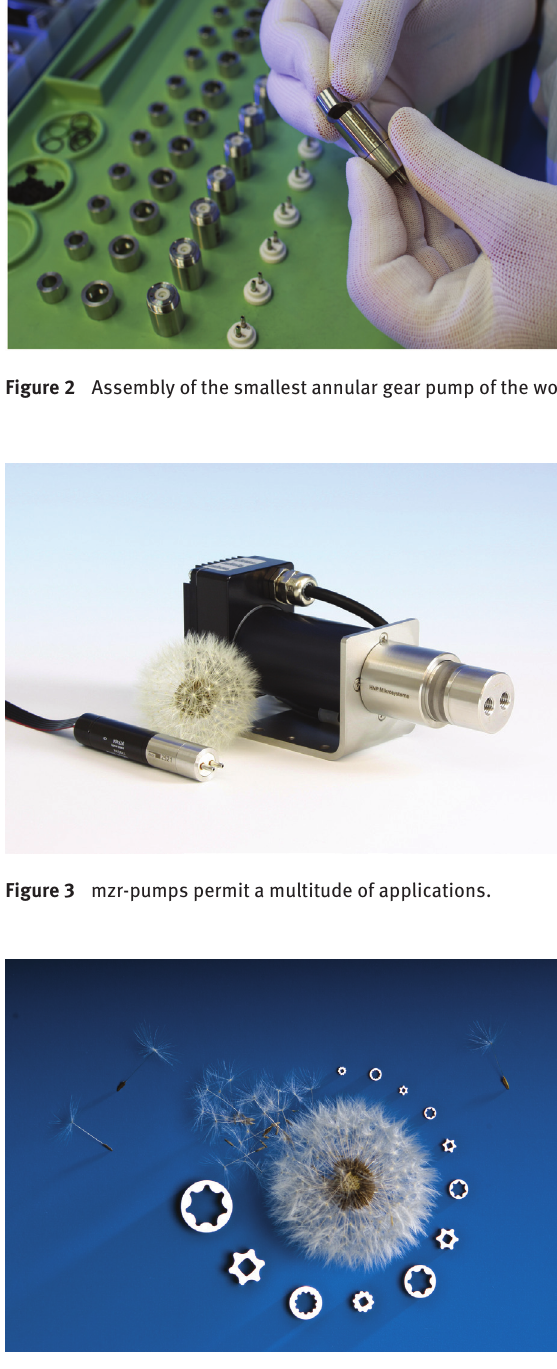
Figure 4 Micron accuracy of functional parts for highest precision in